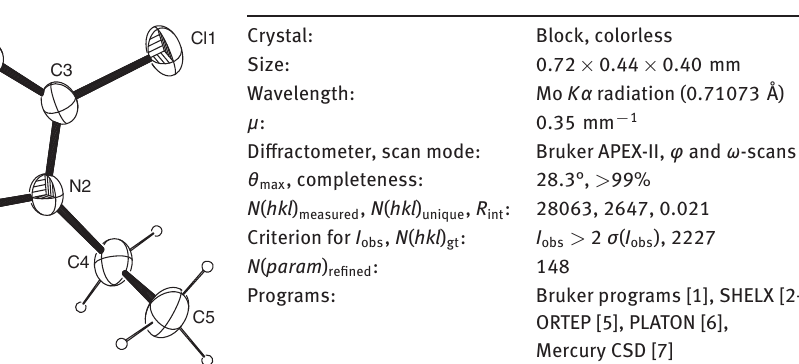
Table 1: Data collection and